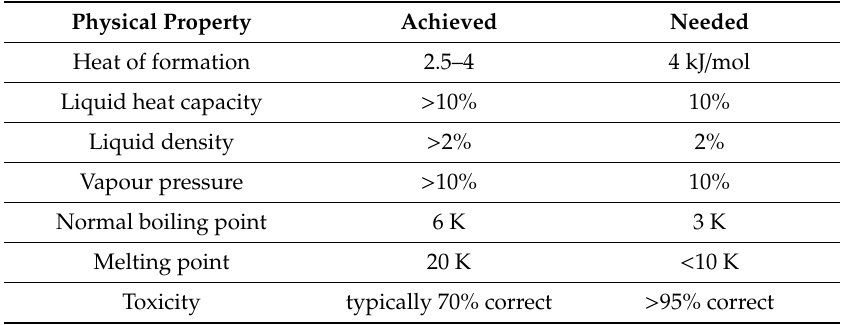
Table 1. Indications of achieved and realistically needed accuracies for various